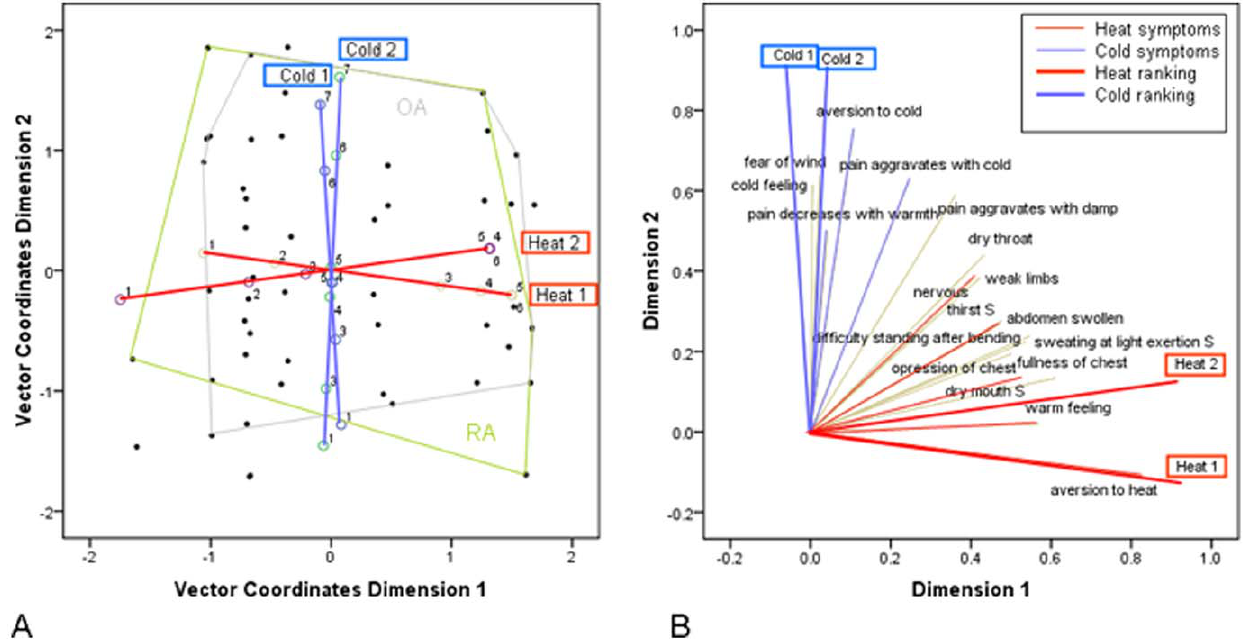
Figure 5. Panel A shows a bi-plot based on a semi-supervised CATPCA model including 19 variables and the 4 expert ranking variables. The four expert rankings are shown on which the categories after transformation are marked by circles. The outline of the group of rheumatoid arthritis (RA) patients is shown as well as the outline of the group of osteoarthritis patients (OA). In Panel B the loadings are shown. The loadings corresponding to symptoms which are related to Cold or Heat according to theory are represented by thin blue or red lines respectively. The Cold and Heat expert rankings are the thick blue en red lines respectively.